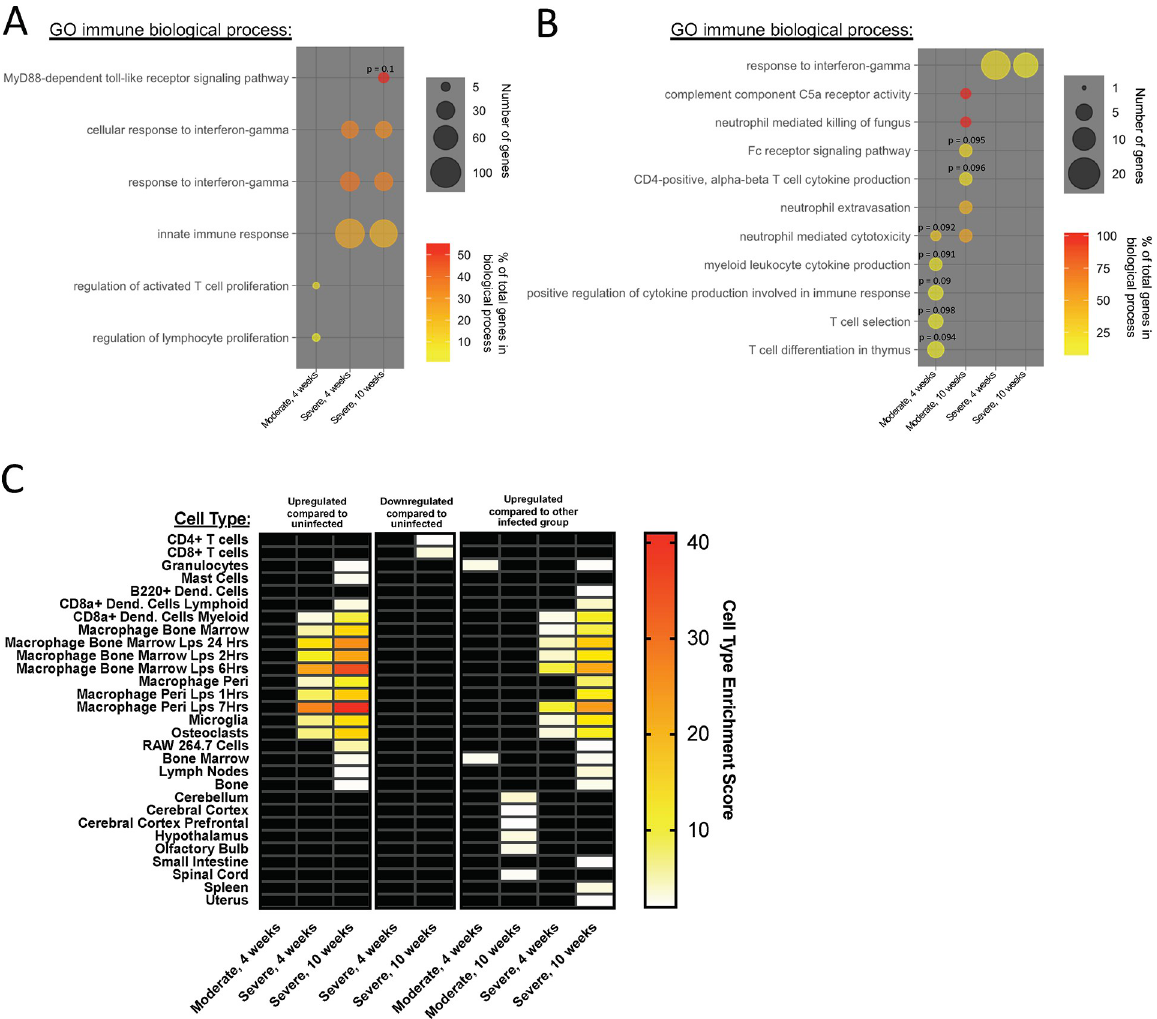
Fig 6. Severely-affected cattle show biases towards innate immune biological processes and cell types. (A-B) Significantly enriched immune biological processes in infected compared to uninfected cattle (A) and one cluster of infected cattle compared to the other infected cluster (B). Processes with corrected p-values < 0.1 were included. P-values are indicated for processes with a corrected p-value < 0.05. (C) Heat map of cell type enrichment scores from comparisons of uninfected, moderately-affected (moderate), and severely-affected (severe) cattle at 4 or 10 weeks post-infection. Cell types that showed significant enrichment in at least one of the comparisons are displayed on the y axis. Comparisons are denoted on the x axis. Heatmap color indicates cell enrichment scores, with larger values indicating higher enrichment scores. Cell enrichment scores greater than 2 were considered significant. Black boxes indicate cell enrichment scores less than 2. Uninfected cattle (n = 5), moderately- affected cattle (n = 3), severely-affected cattle (n =